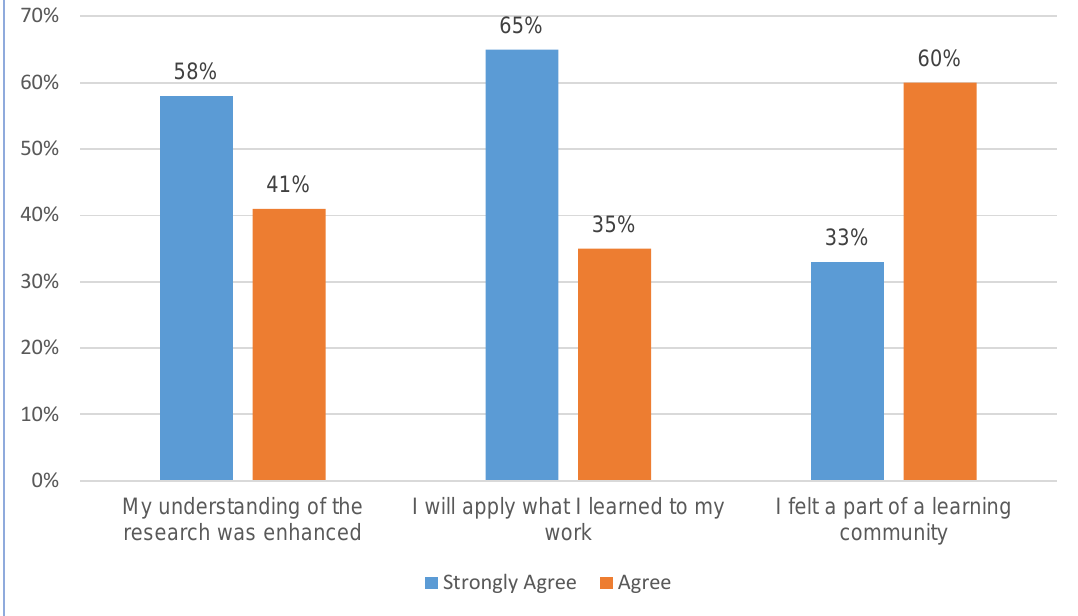
Figure 1: 2010-2019 Overall Course Evaluation (n = 153 respondents)